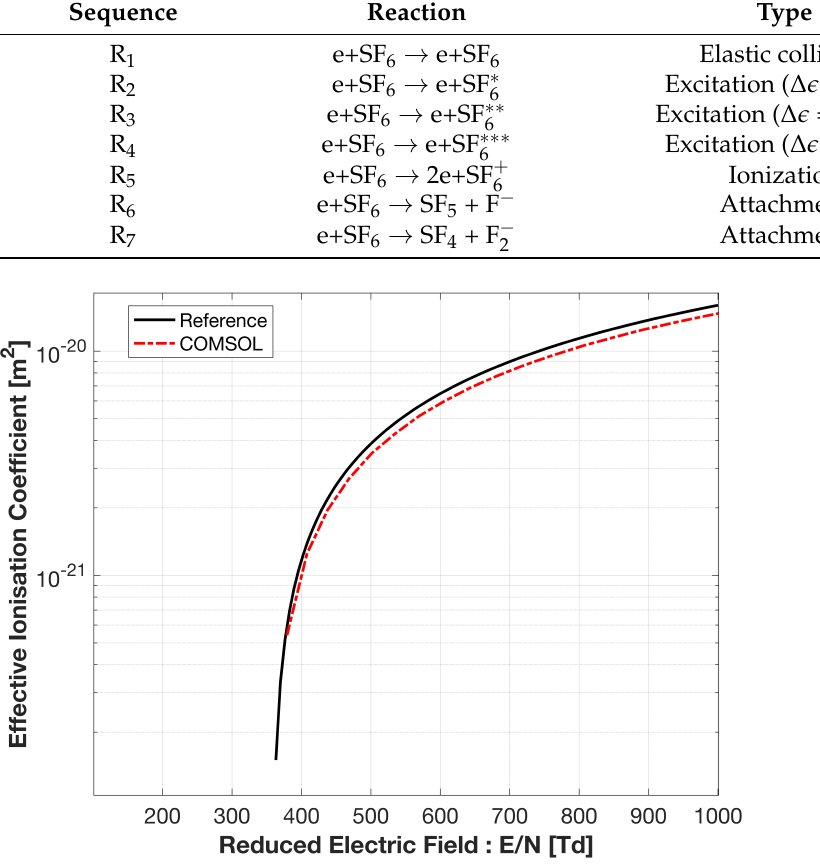
Figure 6. Reduced effective ionization coefficient ¯ α / N in logarithmic scale, for pure SF 6 , determined with reference Equation (16) and calculated with COMSOL ®